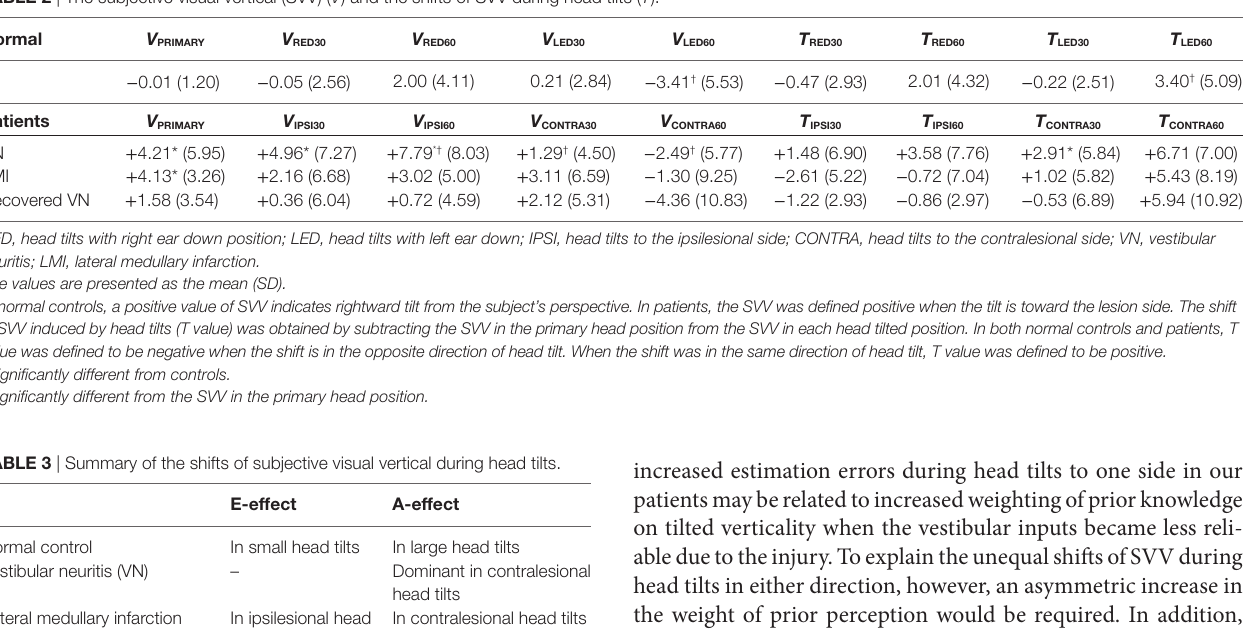
TaBle 2 | The subjective visual vertical (SVV) ( V ) and the shifts of SVV during head tilts ( T ). normal V PriMarY V reD30 V reD60 V leD30 V leD60 T reD30 T reD60 T leD30 − 0.01 (1.20)